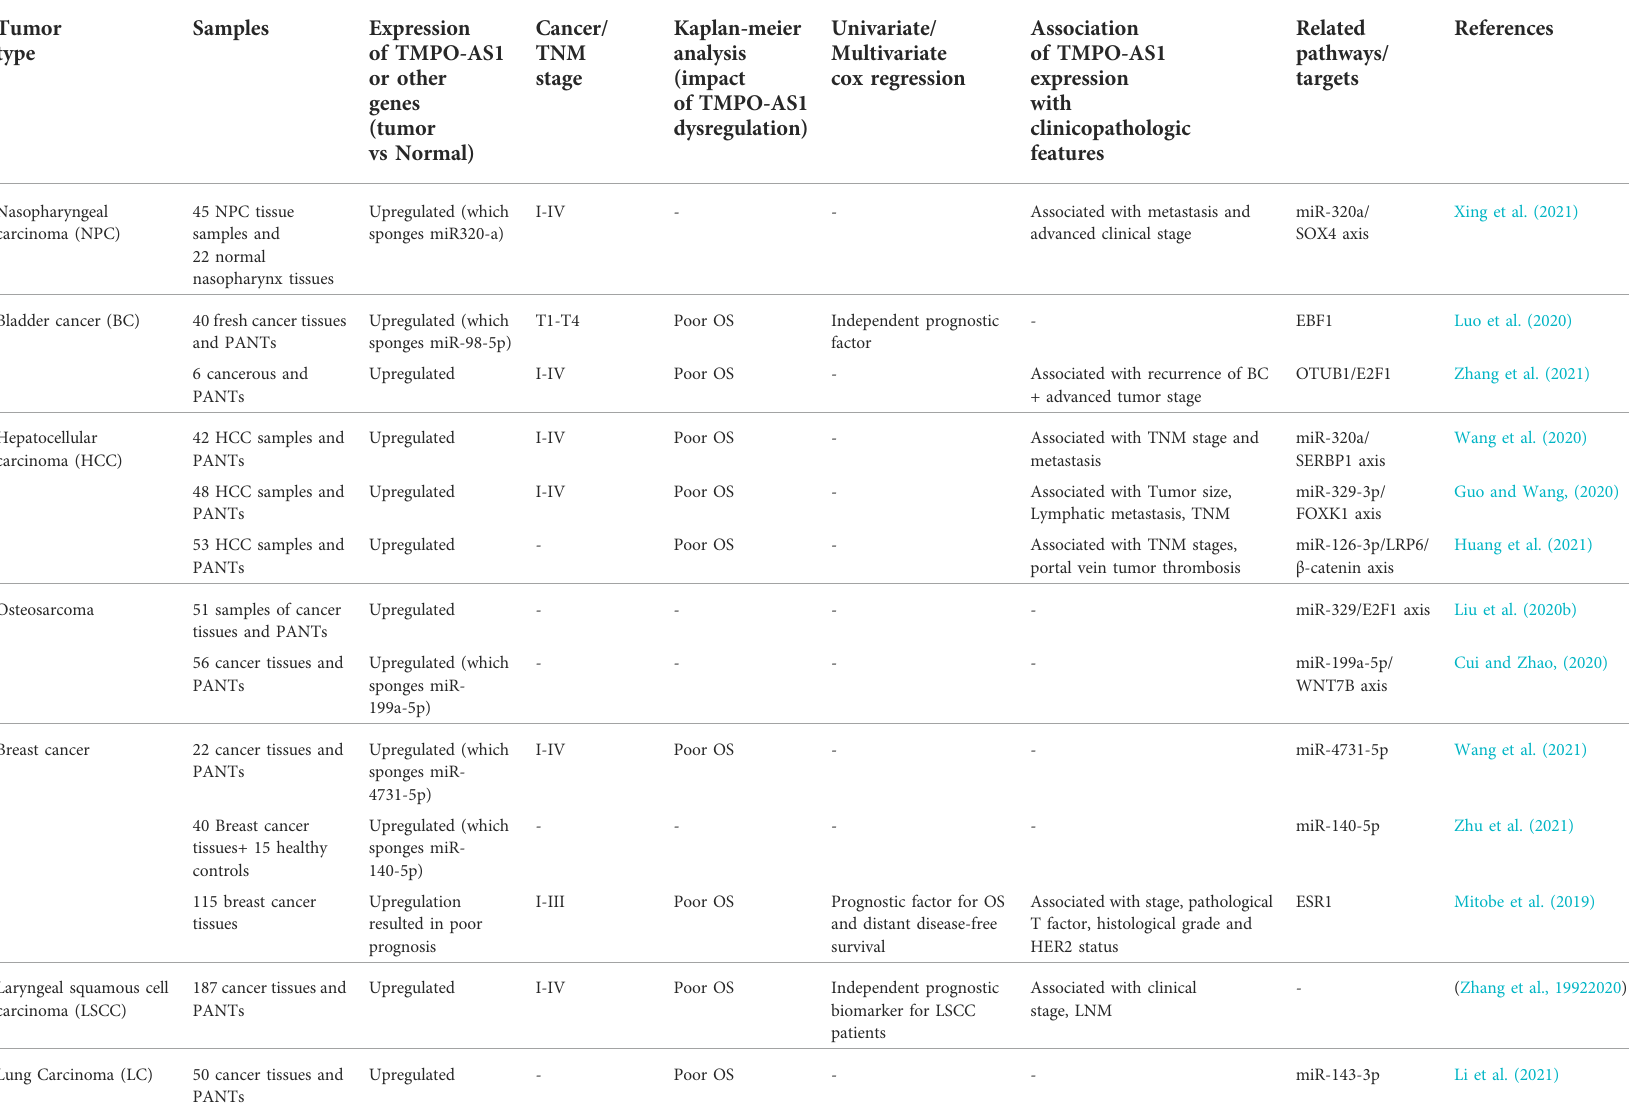
TABLE 3 Dysregulation of TMPO-AS1 or other genes that interact with TMPO-AS1 in clinical specimens (PANTs: paired adjacent normal tissues, OS: overall survival, LNM: lymph node metastasis, BCR: biochemical